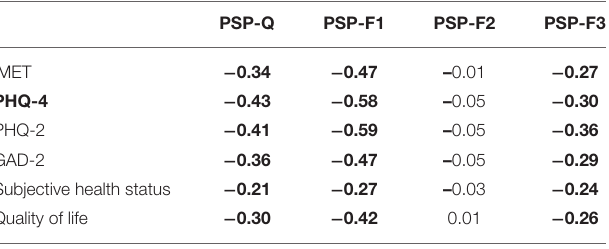
TABLE 3 | Correlation between the PSP-Q and its subscales.